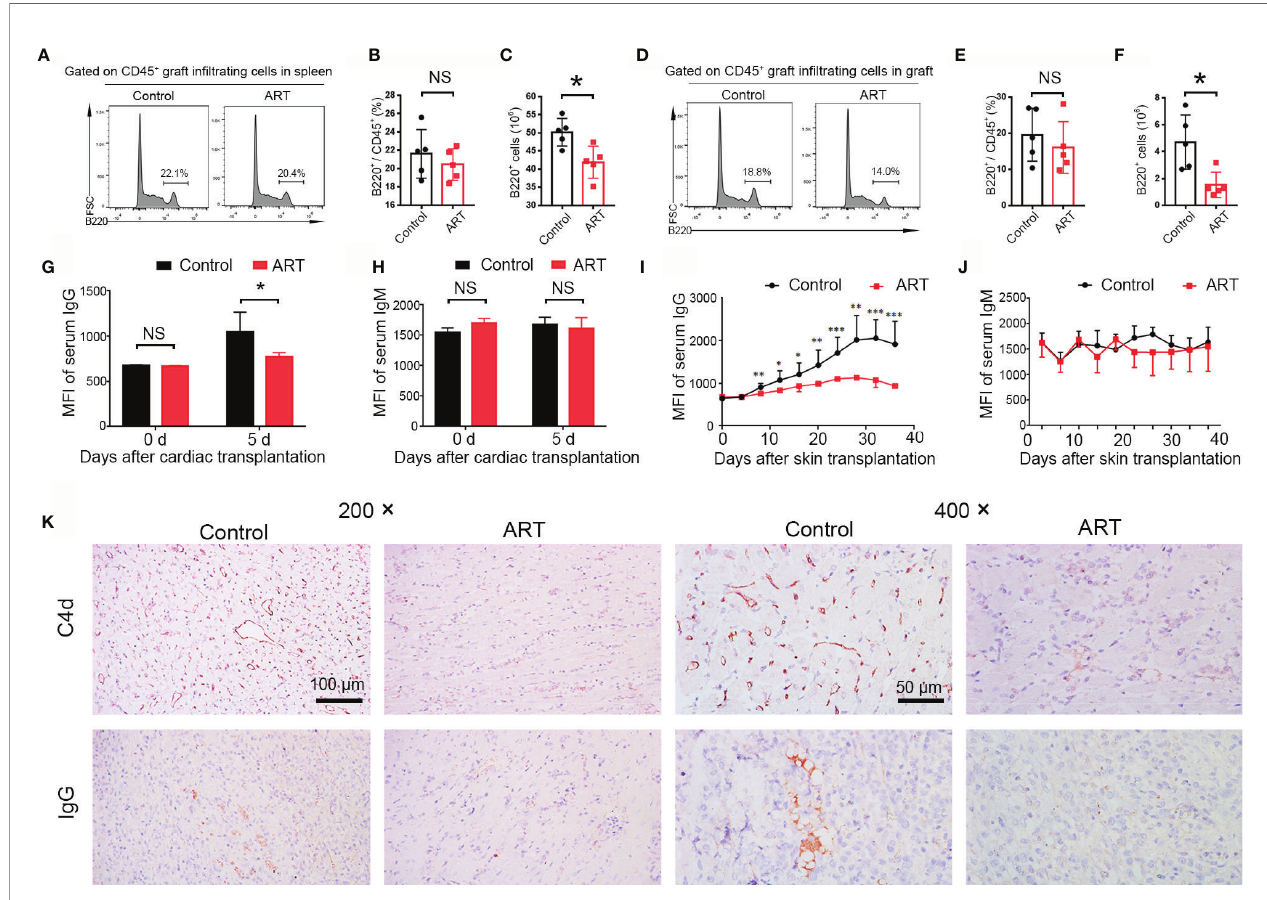
FIGURE 4 | Artemisinin (ART) attenuates antibody-mediated rejection via the inhibition of B cell and donor speci fi c antibody (DSA) production. (A – F) B cells (B220 + ) were detected by fl ow cytometry in fresh spleens and allografts on day 5 after cardiac transplantation. Representative histograms showing the frequencies and counts of B cells in host spleens (A – C) and cardiac grafts (D – F) are presented. (G, H) Changes in DSA levels (IgG and IgM) on day 0 and 5 after cardiac transplantation (n = 5). (I, J) Changes in DSA levels (IgG and IgM) after Lewis rats that received skin allografts from BN donors were treated with (ART group) or without ART (control group) for 36 days. (K) Representative immunohistochemistry stained images showing the deposition of C4d and IgG. Magni fi cation: 200× and 400×. * P < 0.05; ** P < 0.01; *** P < 0.001. NS, no signi fi